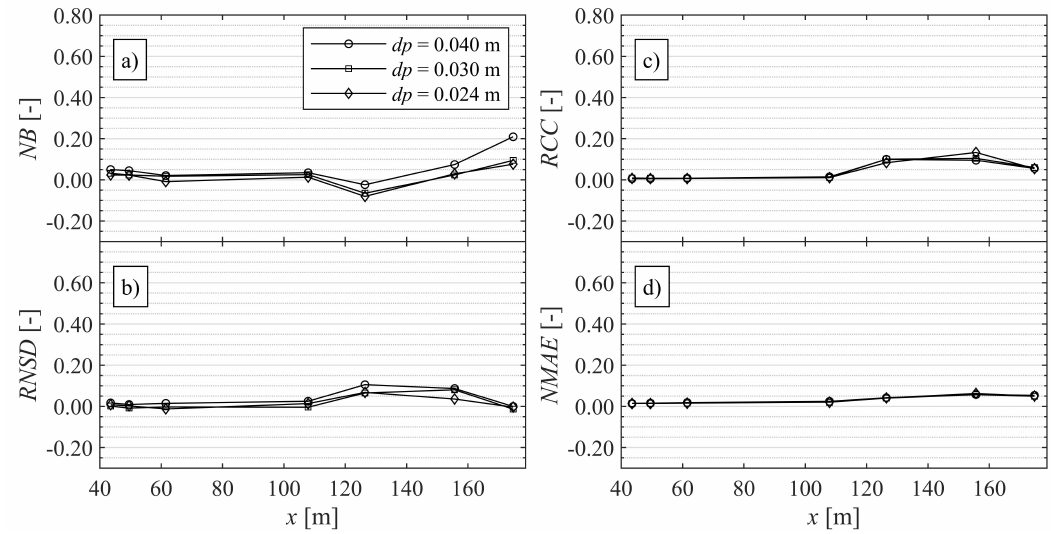
Figure A1. DSPH model inter-particle distance dp convergence analysis of the η time series at the WG locations along the flume up to the dike toe (WG14), based on ( a ) the normalised bias, ( b ) the residual normalised standard deviation, ( c ) the residual correlation coe ffi cient, and ( d ) the normalised mean-absolute-error. The reference is the highest resolution simulation with dp = 0.02 m.